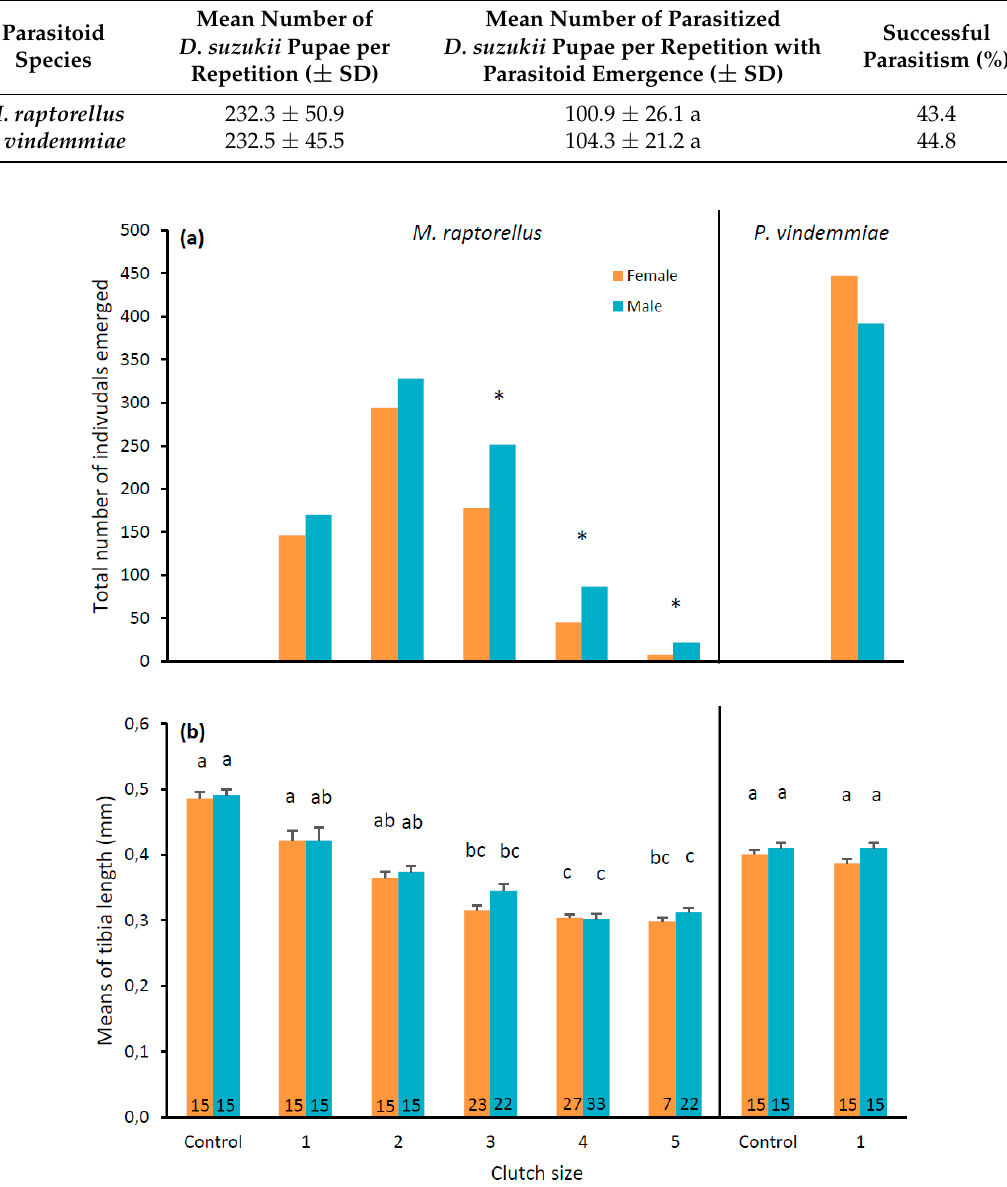
Figure 4. Total number of individuals ( a ) and means ( ± SE) of left hind tibia length ( b ) of M. raptorellus and P. vindemmiae parasitoids that emerged from D. suzukii pupae at various clutch sizes in raspberries under laboratory conditions. Controls were M. raptorellus that emerged from M. domestica pupae and P. vindemmiae that emerged from D. suzukii pupae used in the rearing colony. Asterisks above bars in panel ( a ) indicate male: female ratios different than 1:1 for each clutch size (Chi-square, p < 0.05), and bars with the same letter in panel ( b ) are not significantly different ( M. raptorellus : Kruskal–Wallis post-hoc Dunn’s test p < 0.05; P. vindemmiae : Student’s t -test, p < 0.05) for each sex and parasitoid species. Numbers in bars in panel ( b ) are the individuals measured.